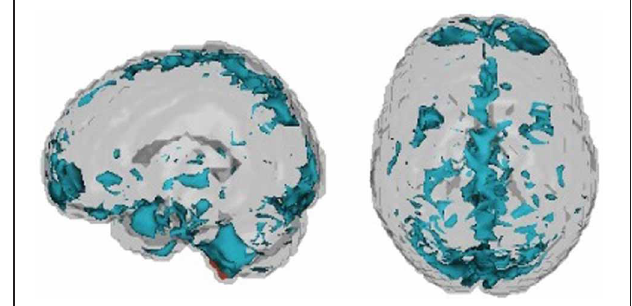
FIGURE 5 | Voxels chosen by CUR